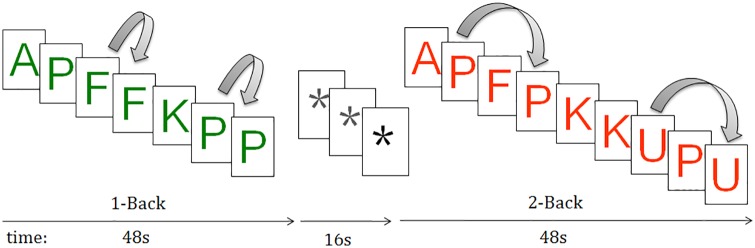
Sequential-letter version of the n-back task with two levels of memory load, 1-back (green) and 2-back (red).